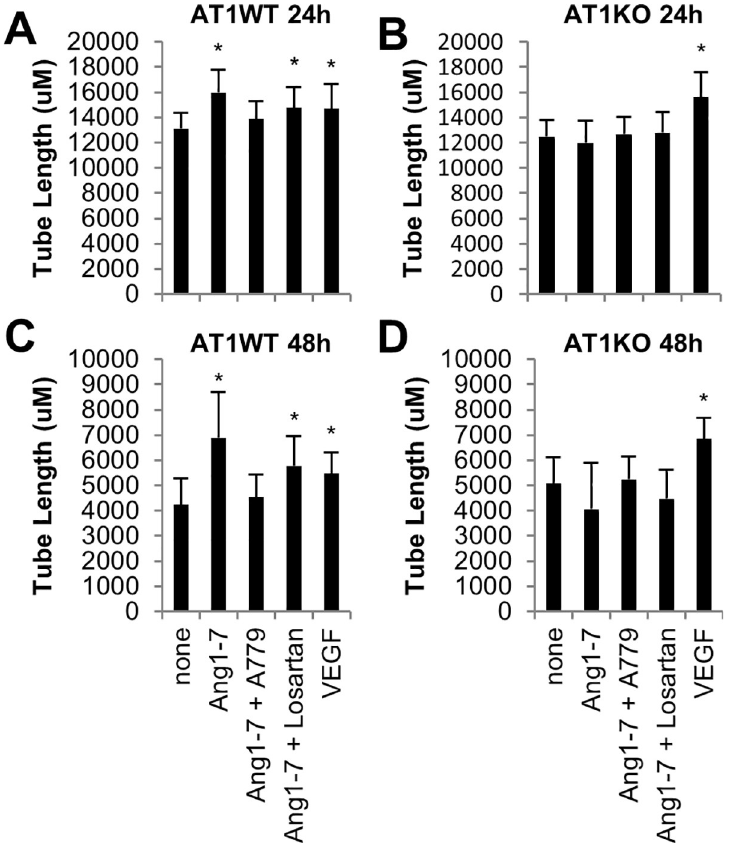
Fig 4. Angiotensin-(1–7) enhances endothelial cell tube formation in SS-AT1WT but not SS-AT1KO endothelial cells. Endothelial cells spontaneously form tube-like structures when cultured in a basement-membrane like matrix. A. SS-AT1WT endothelial cell tube length at 24 hours. B. SS-AT1KO endothelial cell tube length at 24 hours. C. SS-AT1WT endothelial cell tube length at 48 hours. D. SS-AT1KO endothelial cell tube length at 48 hours. Bars represent mean +/- standard deviation ( � p < 0.05 vs none via 1-way ANOVA with Dunnett’s Method for multiple comparisons). None = control, Ang1-7 = angiotensin-(1–7), A779 = Mas1 antagonist, Losartan = AT1 antagonist, VEGF = vascular endothelial growth